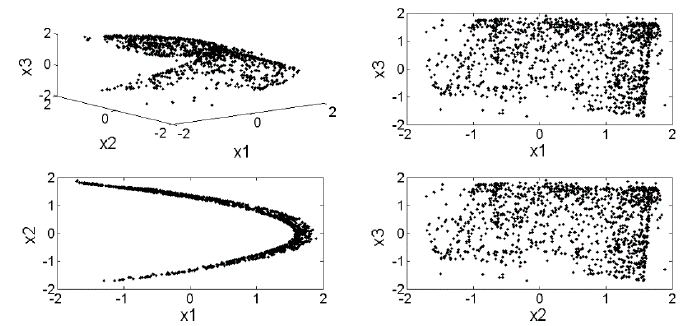
Figure 1. Strange attractors of the master Henon map.